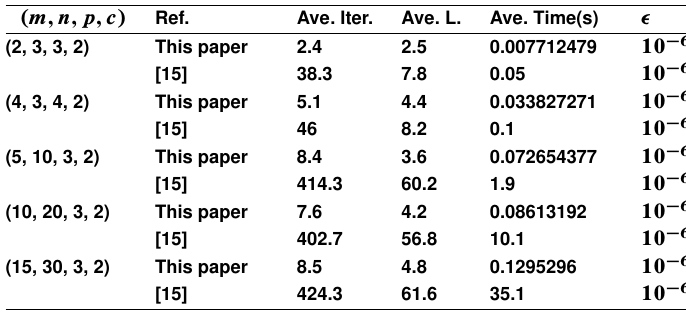
Table 2. Numerical results for Examples